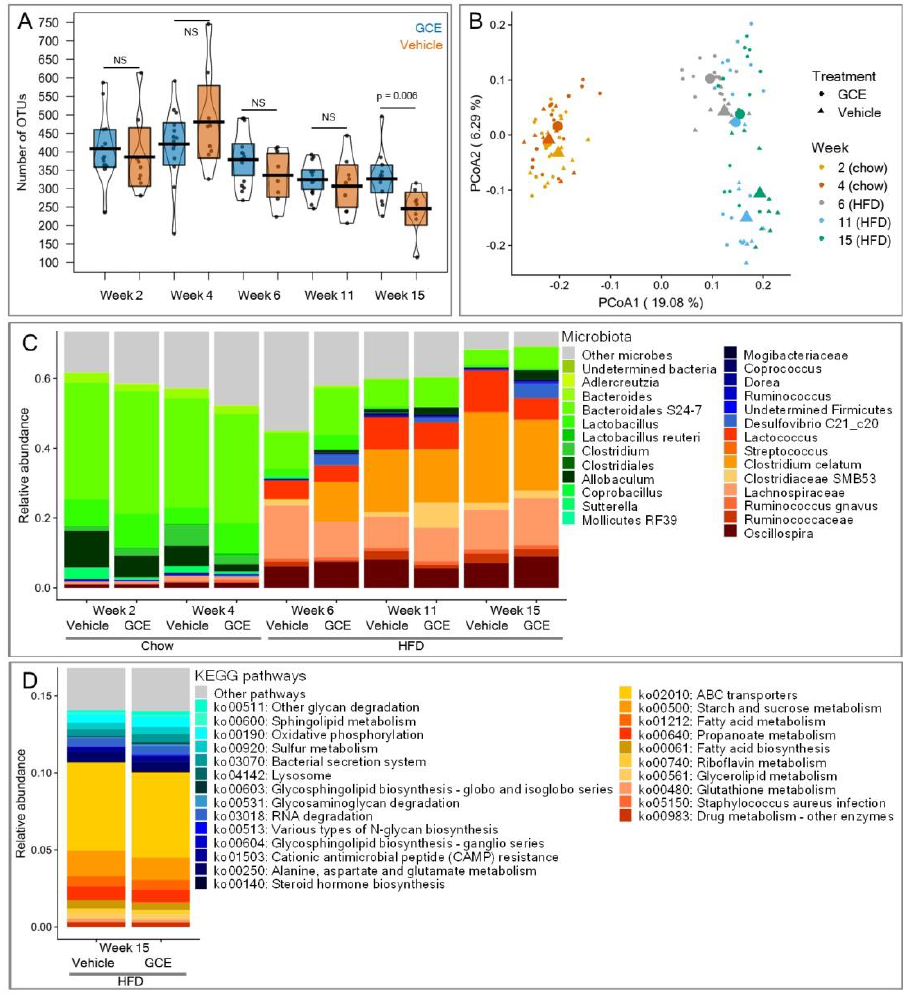
Figure 6. Green coffee extract ( GCE) treatment in ApoE -/- high-fat diet (HFD)-fed mice is associated with changes in gut microbiota. ( A ) The number of observed operational taxonomic untis (OTUs, alpha diversity) diminished with time and was significantly higher in the GCE-treated mice (blue boxes) than in the vehicle-treated mice (orange boxes) at the end of experiments (Week 15). ( B ) The chow-to-HFD shift prompted strong modulation of gut microbiota, which was further modified by GCE. Principal coordinates analysis (PCoA) on unweighted UniFrac distances (beta diversity) showed changes in gut microbiota throughout experiments and time. The centroids of each treatment and time point are highlighted with larger points. Percentages on the axes represent the proportion of explained variation of each component of the PCoA. ( C ) Median relative abundance of microbes significantly associated with the chow diet (green tones), the HFD (red tones), or GCE (blue tones). ( D ) Median relative abundance of Kyoto Encyclopedia of Genes and Genomes (KEGG) pathways associated with gut microbiota of mice treated with vehicle (red tones) or GCE (blue tones) at the end of experiments (Week 15).